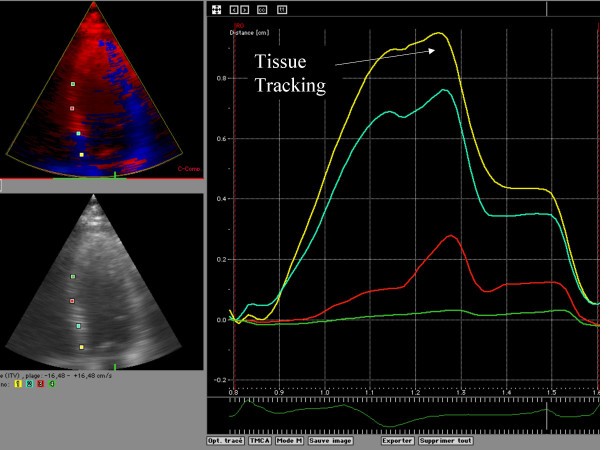
Example of Tissue tracking curves displayed on Echopac. It was there easy to record the peak (S) of systolic displacement of the same 4 ROI described in figure 1.